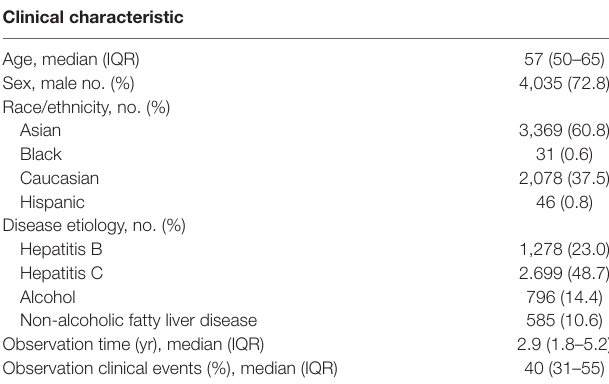
TABLE 1 | Clinical demographics of subjects in MPIC